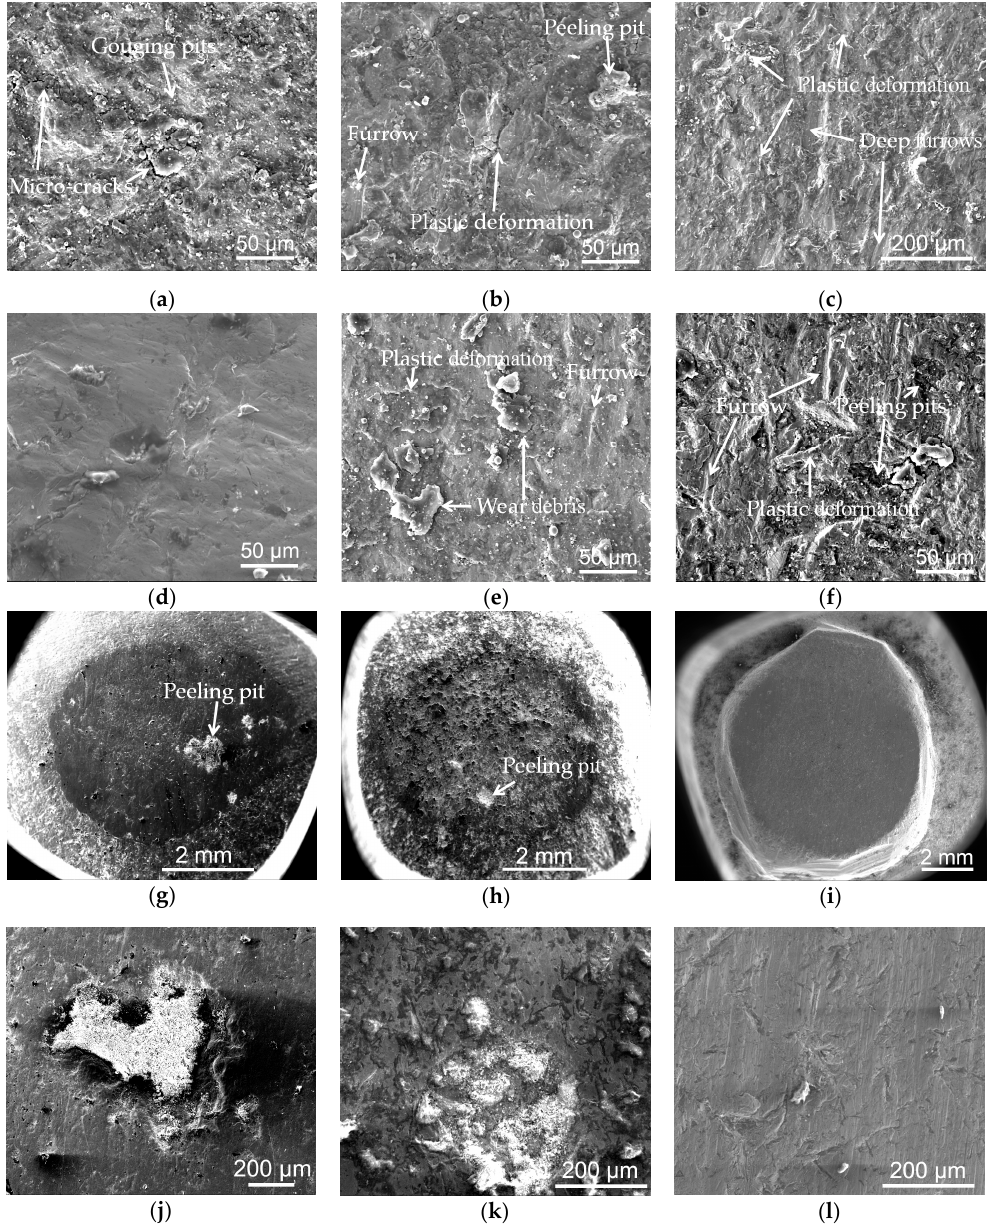
Figure 9 . Morphologies of the worn surface: ( a – c ) The Hadfield steel: the glass sand, the granite, and the quartz sand, respectively; ( d – f ) The over-lapped cladding layer: the glass sand, the granite, and the quartz sand, respectively; ( g – i ) The dot-shaped layer: the glass sand, the granite, and the quartz sand, respectively; ( j – l ) Close-views of the top zone of the dot-shaped layer: the glass sand, the granite, and the quartz sand, respectively.